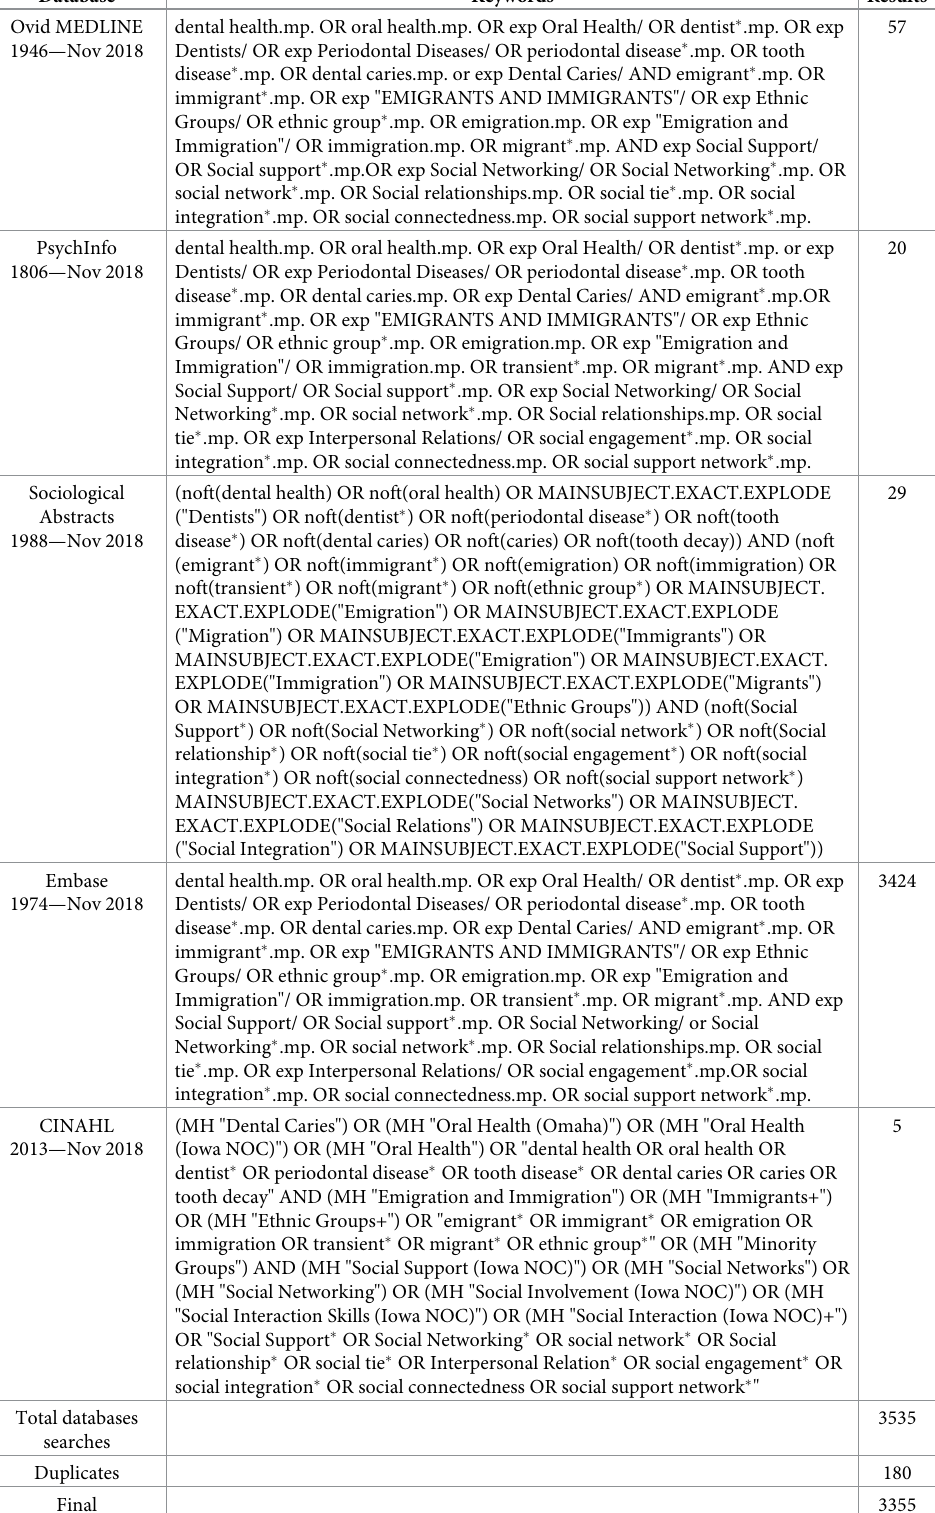
Table 1. Search strategy and results from different electronic